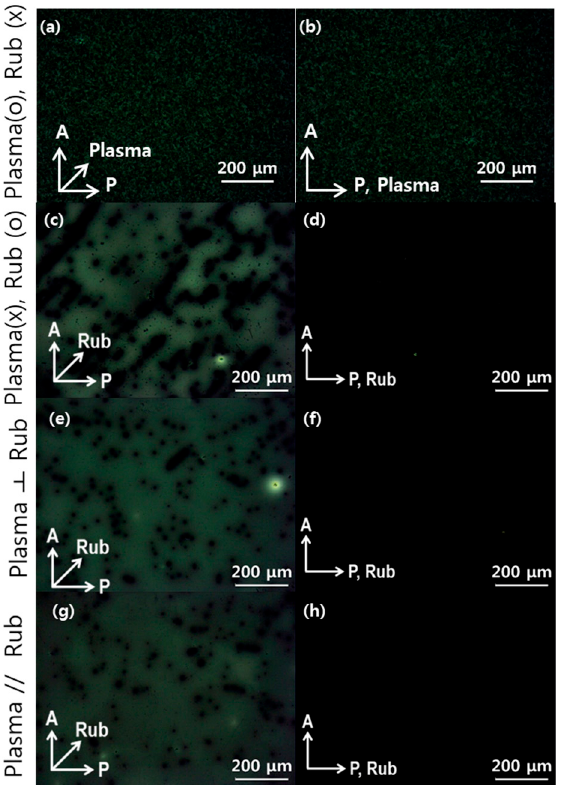
Figure 3. Polarizing optical microscopy (POM) images of the HCM009 samples located between crossed polarizers. PVA was used as an alignment layer. Plasma was treated but not rubbed in ( a , b ). Rubbed but plasma was not treated ( c , d ). The plasma direction was perpendicular to the rubbing direction in ( e , f ), while it was parallel to the rubbing direction in ( g , h ). The rubbing direction of the samples was at 45 o in ( a , c , e , g ) and 0 ◦ in ( b , d , f , h